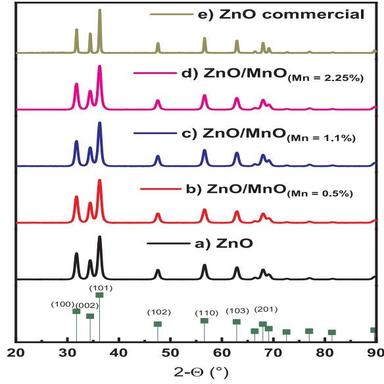
XRD patterns of a) ZnO, MnO/ZnO with b) Mn = 0.5%, c) Mn = 1.1% and d) Mn = 2.25% and e) commercial ZnO, bottom of figure peaks from hexagonal wurtzite phase JCPDS 36-1451.